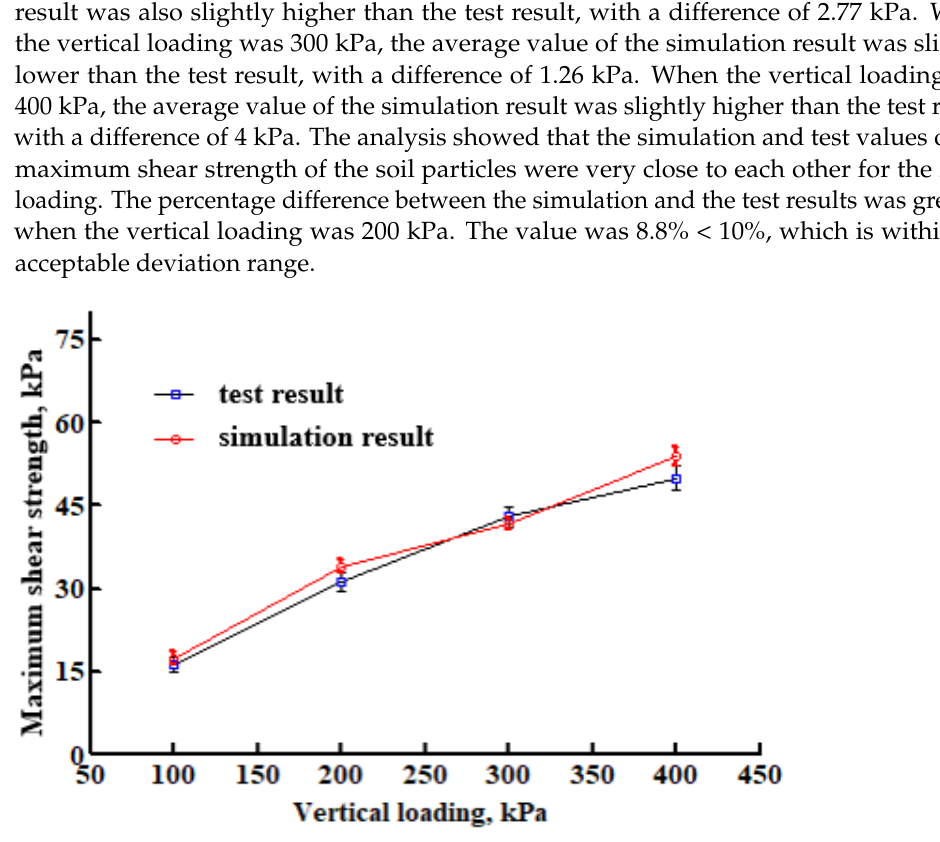
Figure 16. Comparison of simulation and test results for shear strength under different vertical load-